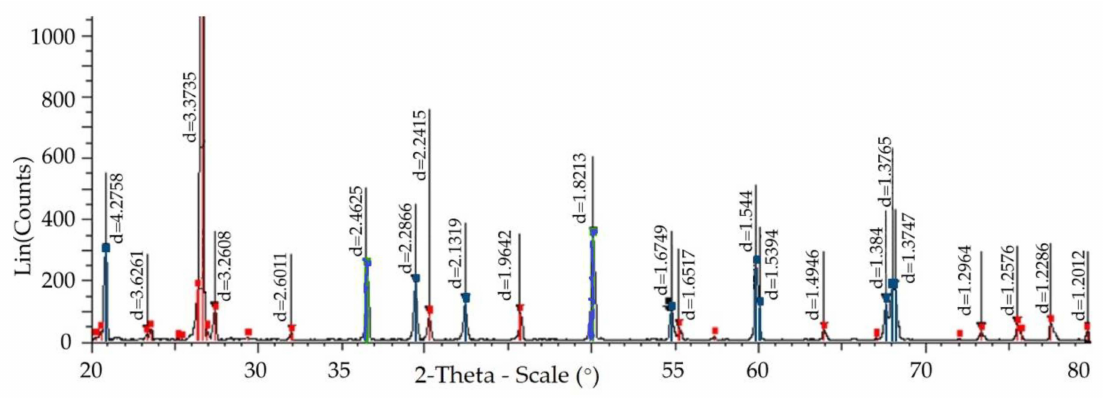
Figure 7. Diffractogram of the structure of a quartzite dried at 200 ◦ C and cooled to 25 ◦ C.